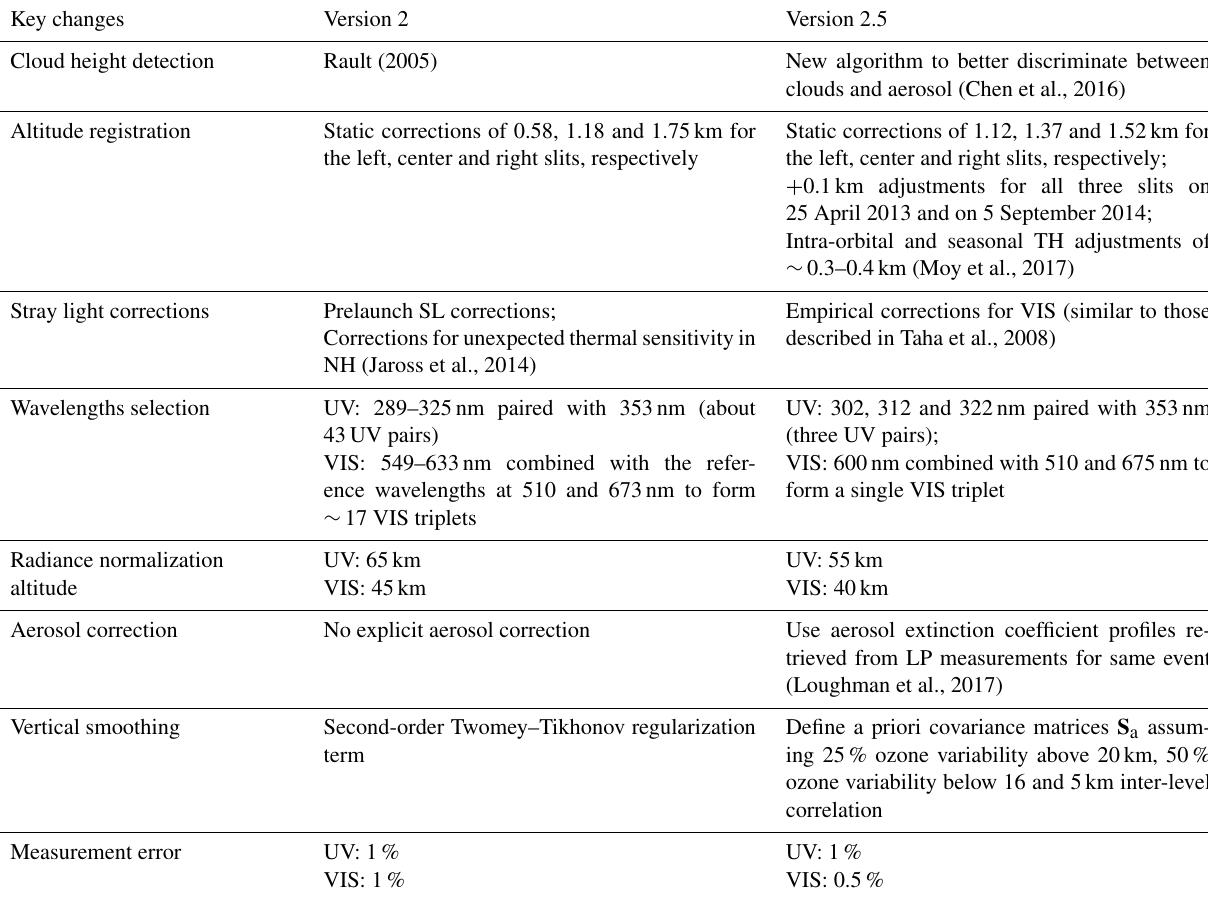
Table 1. Summary of key changes implemented in versions 2 and 2.5 relative to the base algorithm described in Rault and Loughman